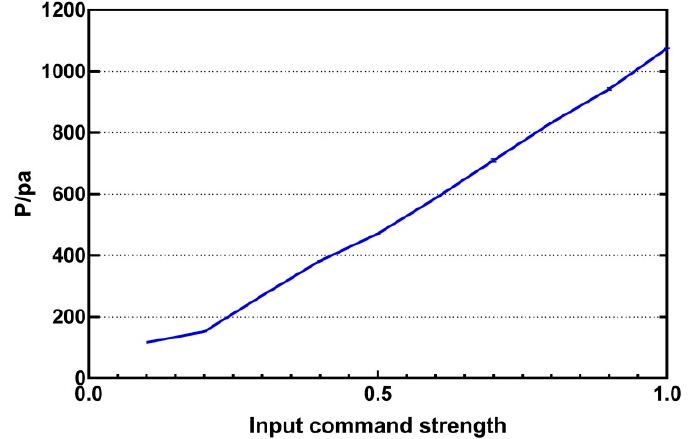
Figure 5. The relationship between input command intensity and output intensity. In order to judge the influence of the distance to the centre on the intensity of the focus, all other parameters remain unchanged, the frequency was 240 HZ, the height was 200 mm, and the input intensity was 1. The distance from the centre to the target was 9 mm and the maximum distance was 81 mm. The distance was the Euclidean distance from the focal point to the centre. The result is shown in Figure 6. It can be seen that as the focal point moves away from the centre point, the pressure intensity decreases monotonously and presents a non-linear relationship.